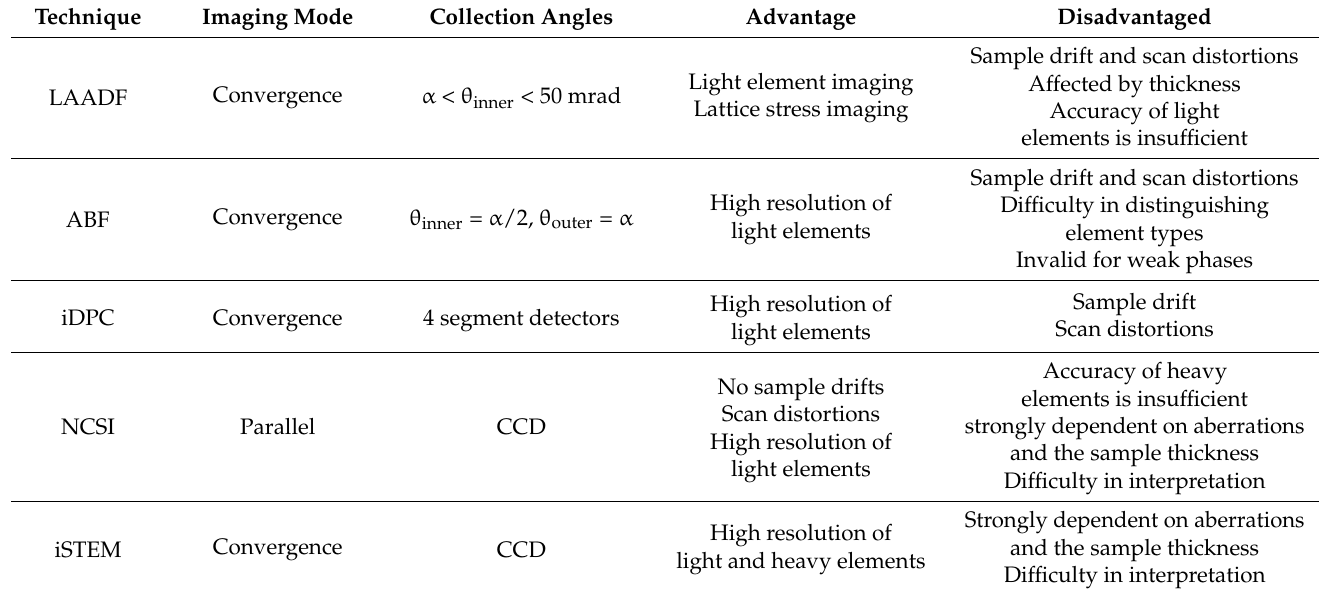
Table 1. Comparison of five light-element imaging modes, including imaging mode, collection angles, and (dis)advantages.